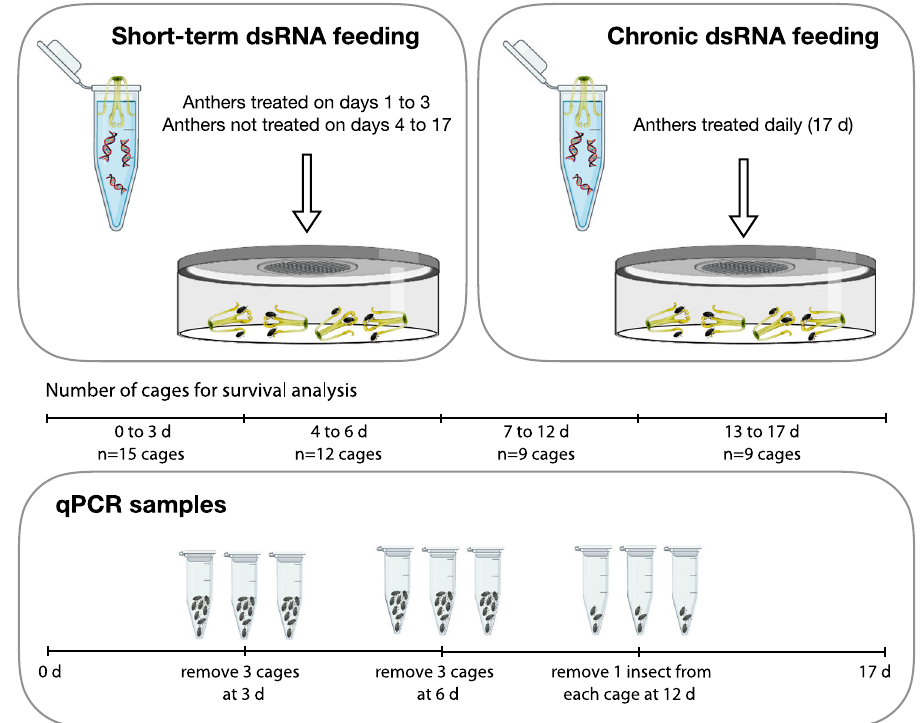
Fig. 3 Experimental setup for each treatment (ds α COP at 0.5, 2.5 and 5 µ g/ µ L, and dsGFP at 5 µ g/ µ L) for both short-term (3 days) and